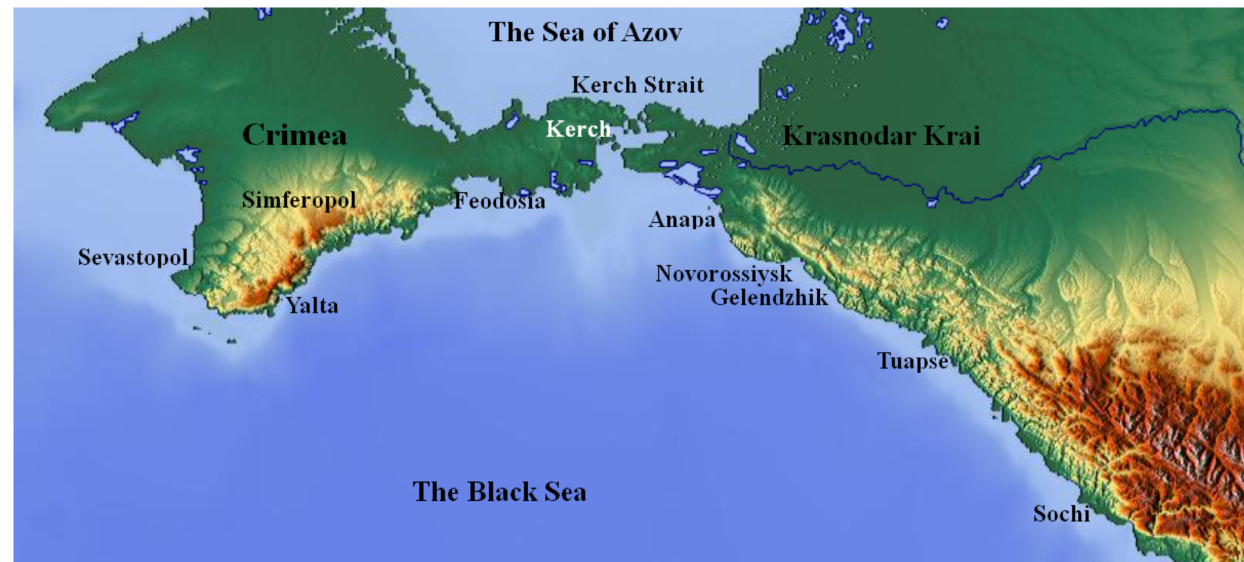
Figure 1. Geographical map of the Northeastern Black Sea based on Maps-For-Free (https://maps-for-free.com/#close, accessed on 30 August 2021). Blue line is the Kuban River. The Greater Caucasus stretches along the Black Sea